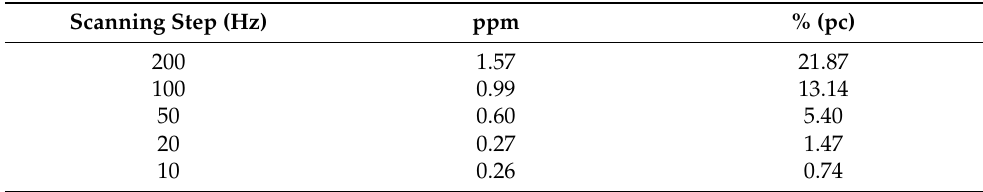
Table 1. Accuracy of measurement of series resonant frequency (ppm) and motional resistance (%) of the QCM sensor in the air according to the scanning step.